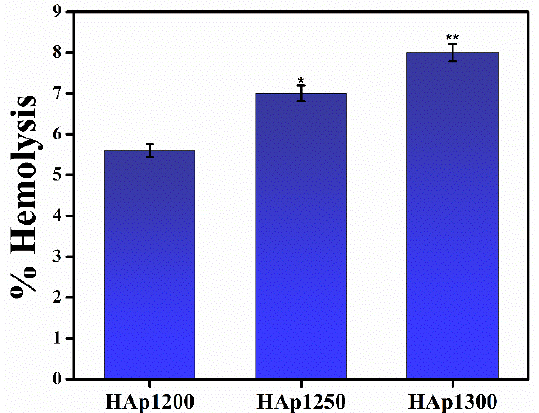
Figure 7. Hemocompatibility assay of HAp samples sintered at different temperatures. * and ** correspond to significant differences at p < 0.05 and p < 0.01, respectively.